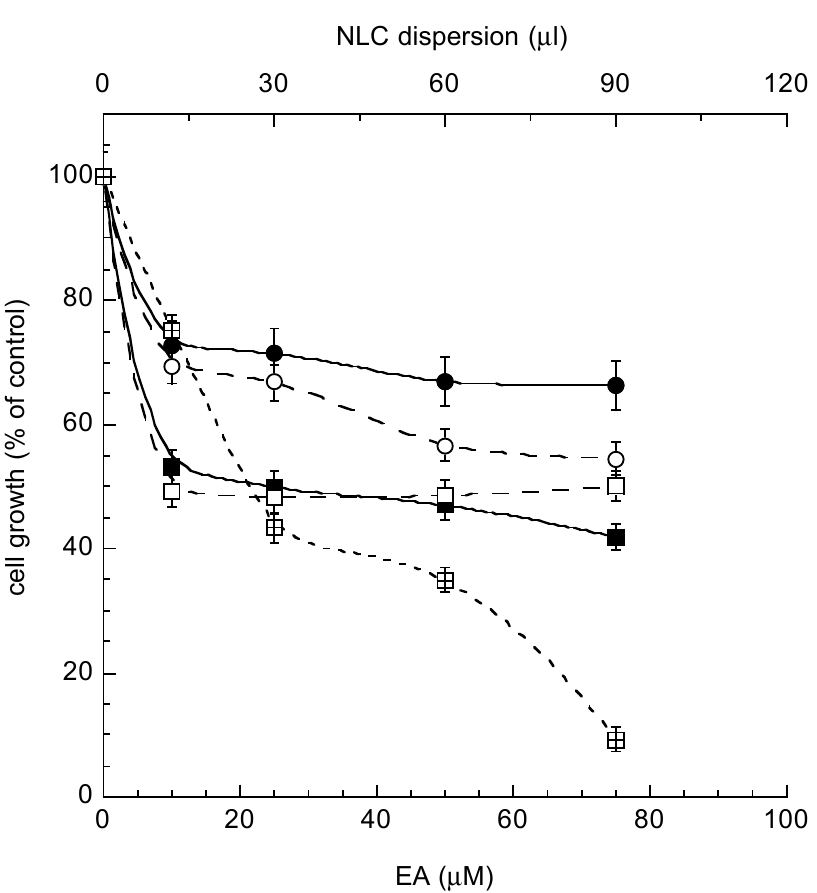
Figure 4. In vitro antiproliferative effect on HaCaT cells of EA in DMSO solution (crossed squares), e-NLC1 (closed circles), e-NLC2 (closed squares), NLC-EA1 (open circles), and NLC-EA2 (open squares). Data are the mean of three independent experiments ± s.d. conducted in triplicate. p- values are always <0.01.